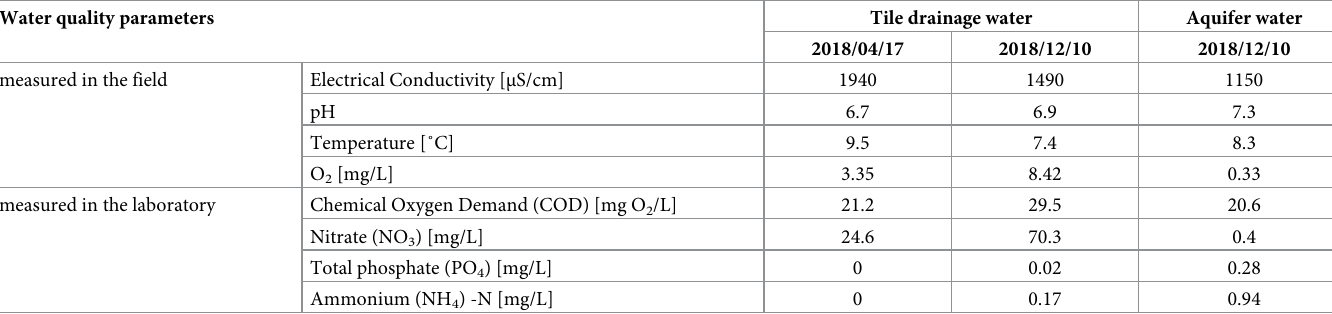
Table 2. Water quality of natural waters at a managed aquifer recharge site. Water quality